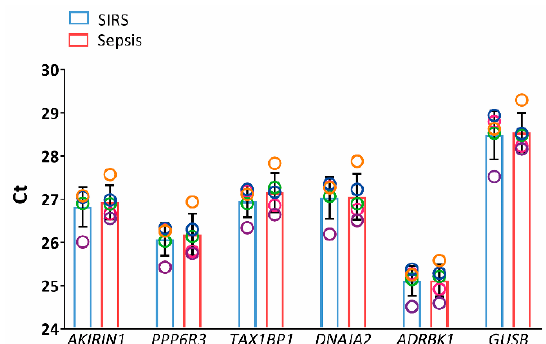
Figure 2. Gene expression analysis in NK cells from the discovery set by RT-PCR (SIRS: blue, sepsis: red). Candidate reference genes identified from microarray and additionally GUSB were tested in five randomly selected discovery set samples from each patient group. Threshold cycle (Ct) values are represented as mean values ± standard deviation (bars). For both groups, data are displayed as circles in a rainbow color scheme to identify values from same cell preparations, i.e., same patients within the respective group. P -values from the Wilcoxon rank-sum test were ≥ 0.69 throughout.